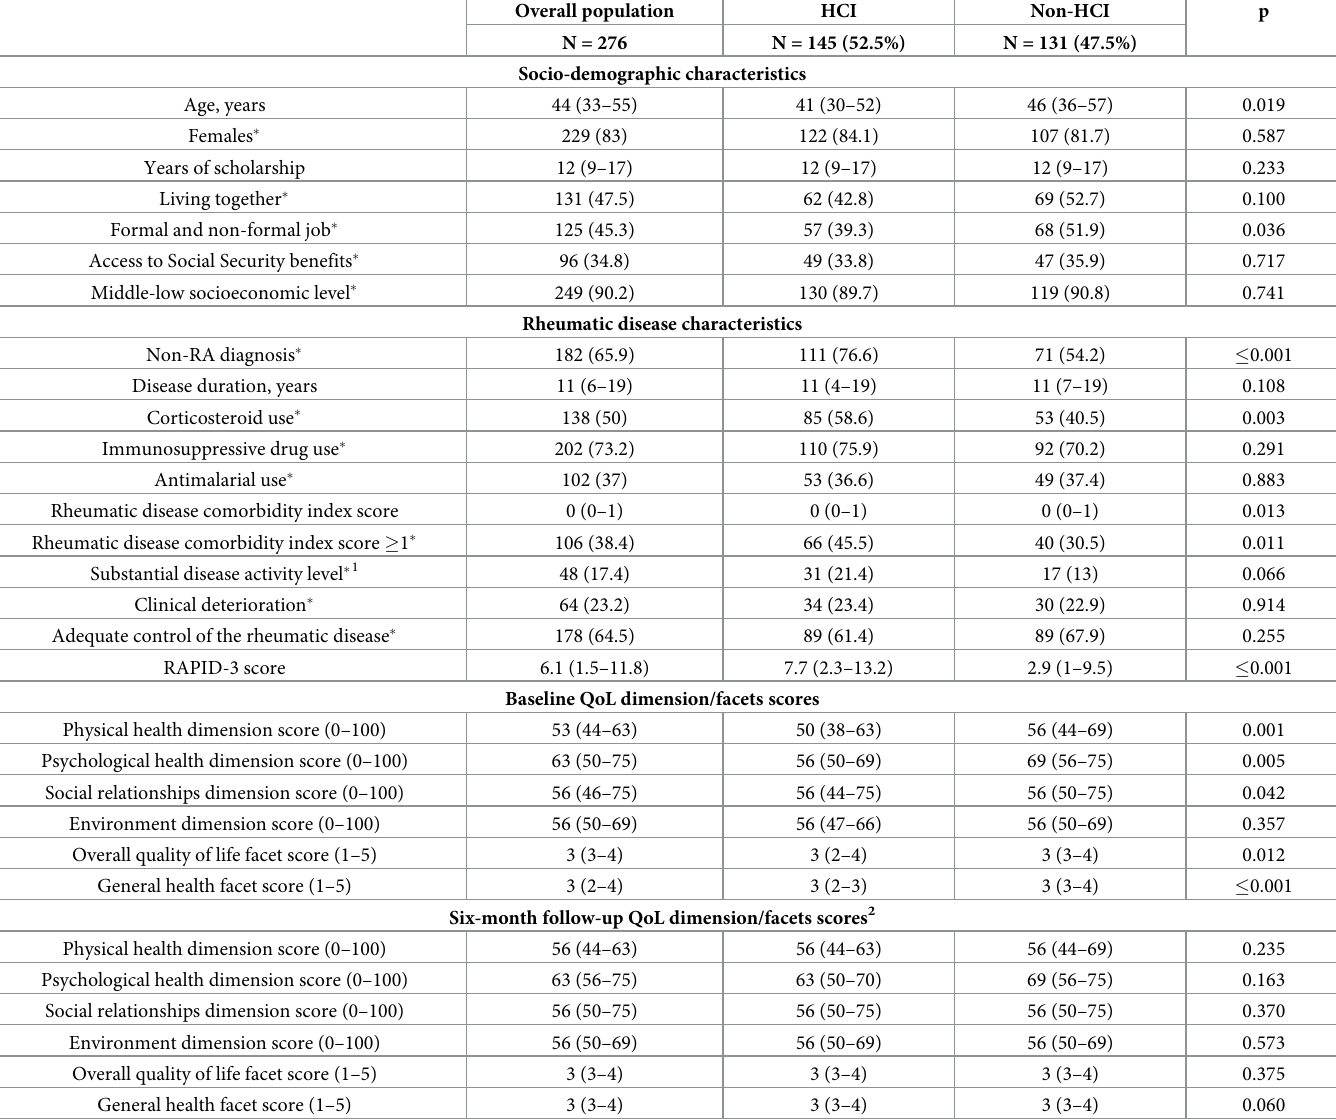
Table 1. Characteristics of the population and their comparison in the subpopulations defined according to HCI/non-HCI: Socio-demography, rheumatic disease- related characteristics and QoL. Overall population HCI Non-HCI p N = 276 N = 145 (52.5%) N = 131